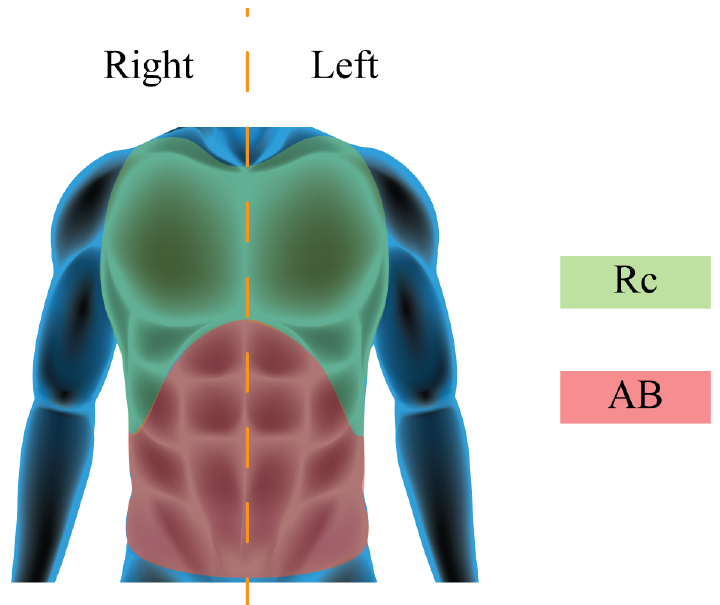
Figure 3. Graphical representation of the chest wall subdivision into 2 main compartments. In green the Rib cage, Rc, and in red the abdomen,